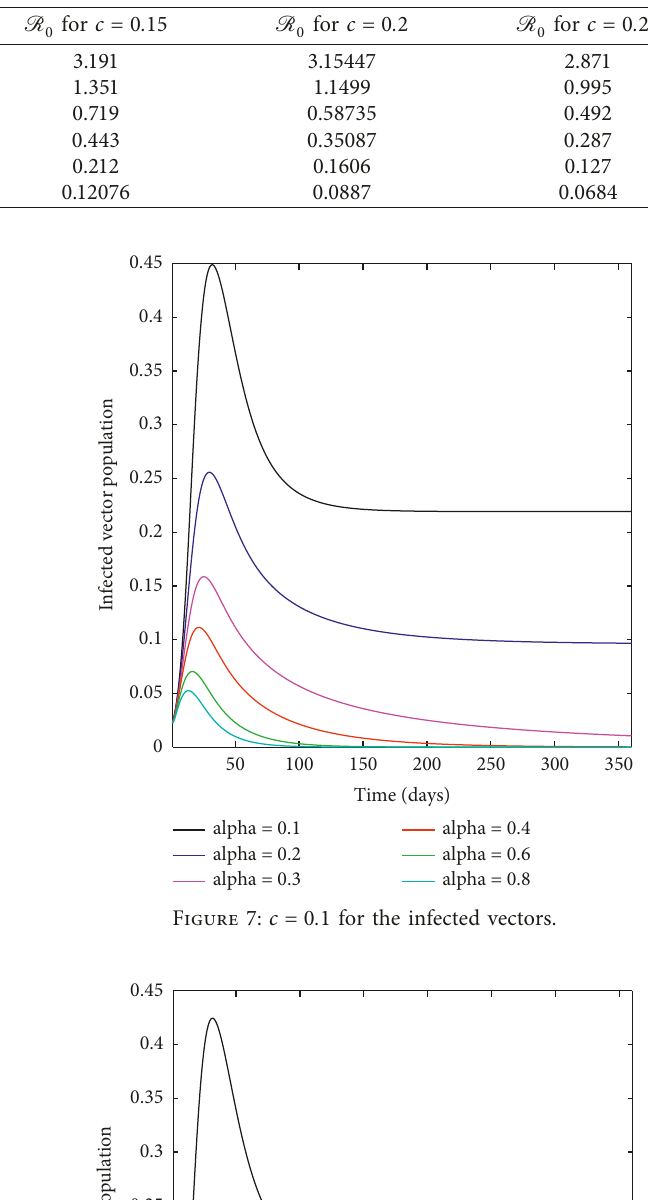
for different c values and different α values. 0